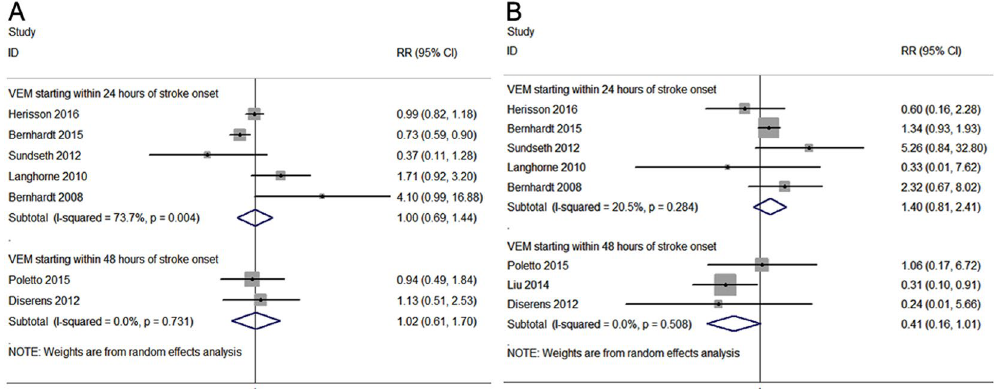
Figure 3. Forest plots of primary efficacy and safety outcomes stratified by starting time of very early mobilization. The diamond indicates the estimated relative risk (RR) (95% confidence interval). The p-value showed on each figure is for heterogeneity test. The modified Rankin Scale (0–2) at 3 months: within 24 hours, p for overall effect = 0.98, Q = 15.20; within 48 hours, p for overall effect = 0.95, Q = 0.12 (A) . Mortality stratified by starting time of VEM: within 24 hours, p for overall effect = 0.23, Q = 5.03; within 48 hours, p for overall effect = 0.05, Q = 1.35 (B) .